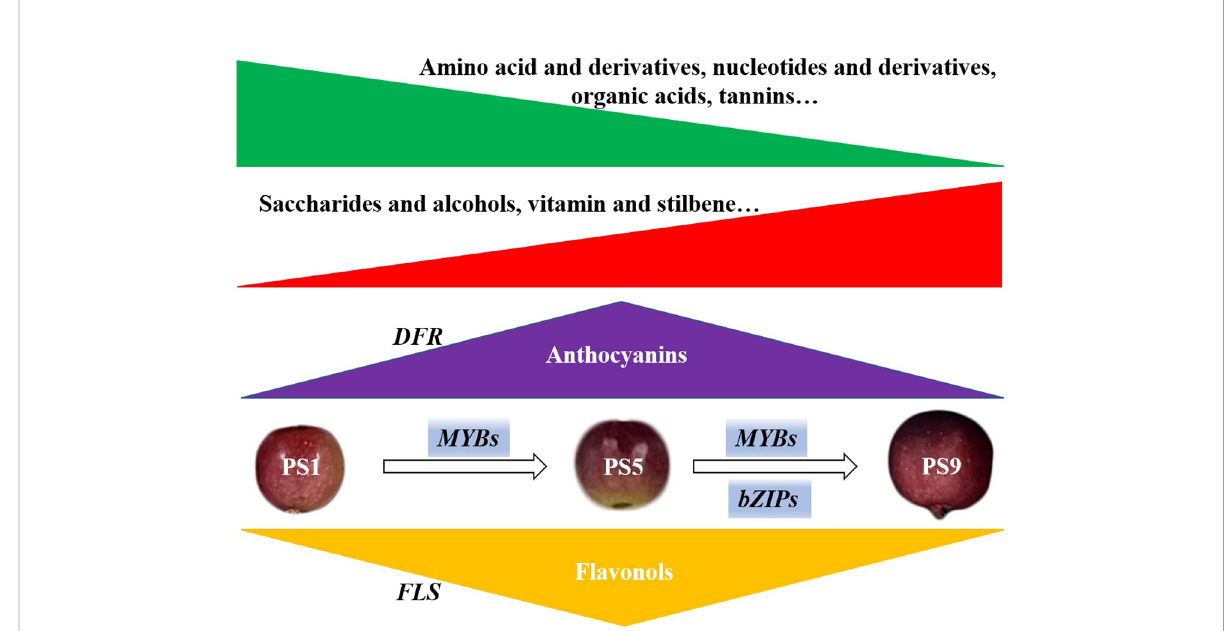
FIGURE 5 Schematic diagram of the molecular changes in red apple fruits during ripening. The green and red triangle represent the decreased and increased change pattern of metabolites. The accumulations of metabolites mostly belonging to amino acids and derivatives, organic acids, nucleotides and derivatives, and tannins reduced with fruit ripening, while the accumulations of metabolites mostly belonging to saccharides and alcohols, vitamins and stilbene increased with fruit ripening. The accumulation of anthocyanins peaked at PS5 and decreased at PS9. However, the fl avonols accumulated least at PS5 but increased at PS9. The differential expression of DFRs and FLSs , functioned greatly to the accumulations of anthocyanins and fl avonols, respectively. Changes in chromatin accessibility and expression of MYBs and bZIPs suggest that they play dominant regulatory roles in the competition for anthocyanins and fl avonols